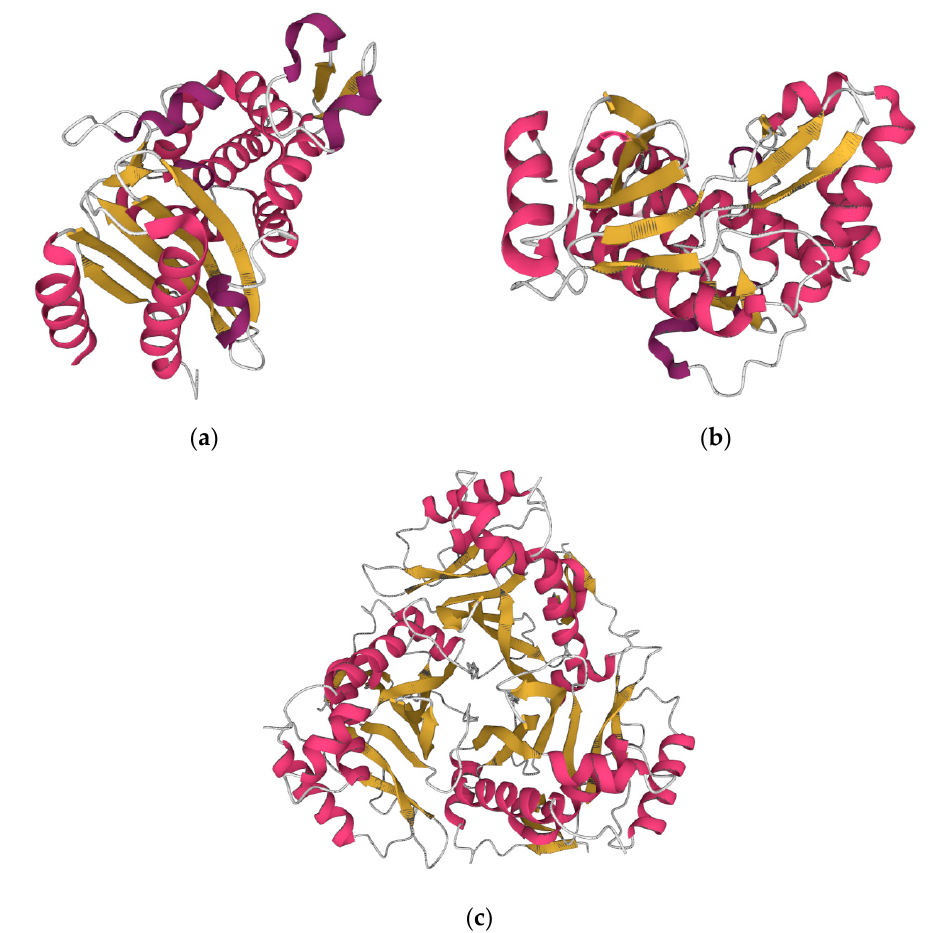
Figure 2. The beta lactamase of Vibrio parahaemolyticus (https://www.rcsb.org/structure/6IZC accessed on 13 December 2022) ( a ). The aminoglycoside-modifying enzyme APH(2’’)—IVa (aminoglycoside phosphotransferase 2’’—IVa) of Enterococcus casseliflavus (https://www.rcsb.org/3d-view/3N4V/1 accessed on 13 December 2022) ( b ). The type III chloramphenicol acetyltransferase of Escherichia coli (https://www.rcsb.org/3d-view/3CLA/1, accessed on 13 December 2022) ( c ).